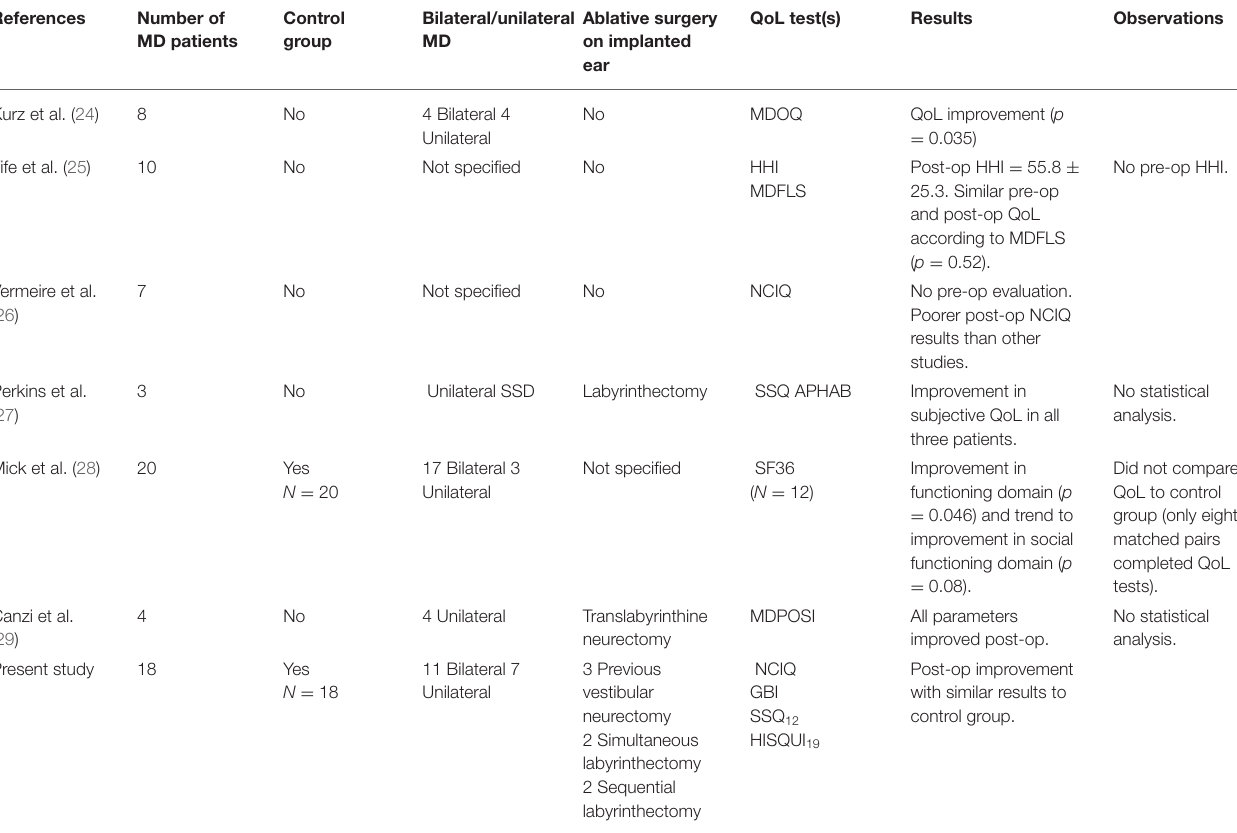
TABLE 5 | QoL publications on patients with MD who undergo